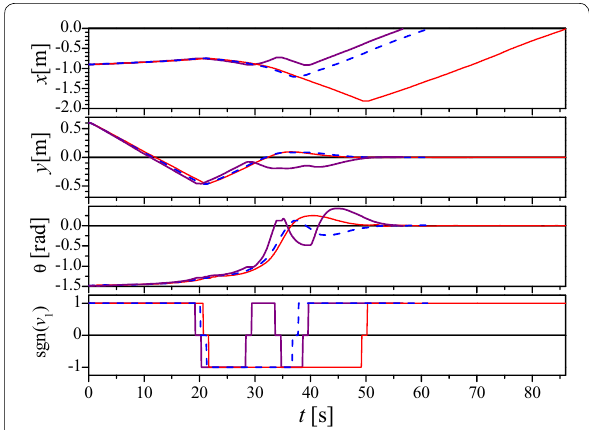
Fig. 13 States and input with different switching